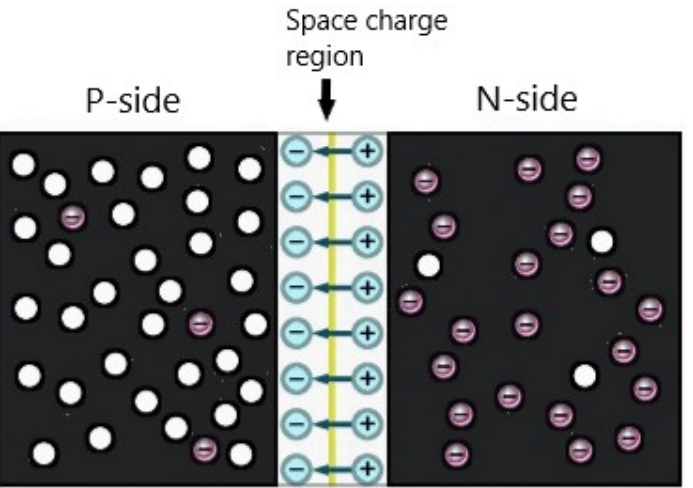
Figure 3. The basic semiconductor form at the instant connection of the p-n sections and generating the electric field in the space charge region.